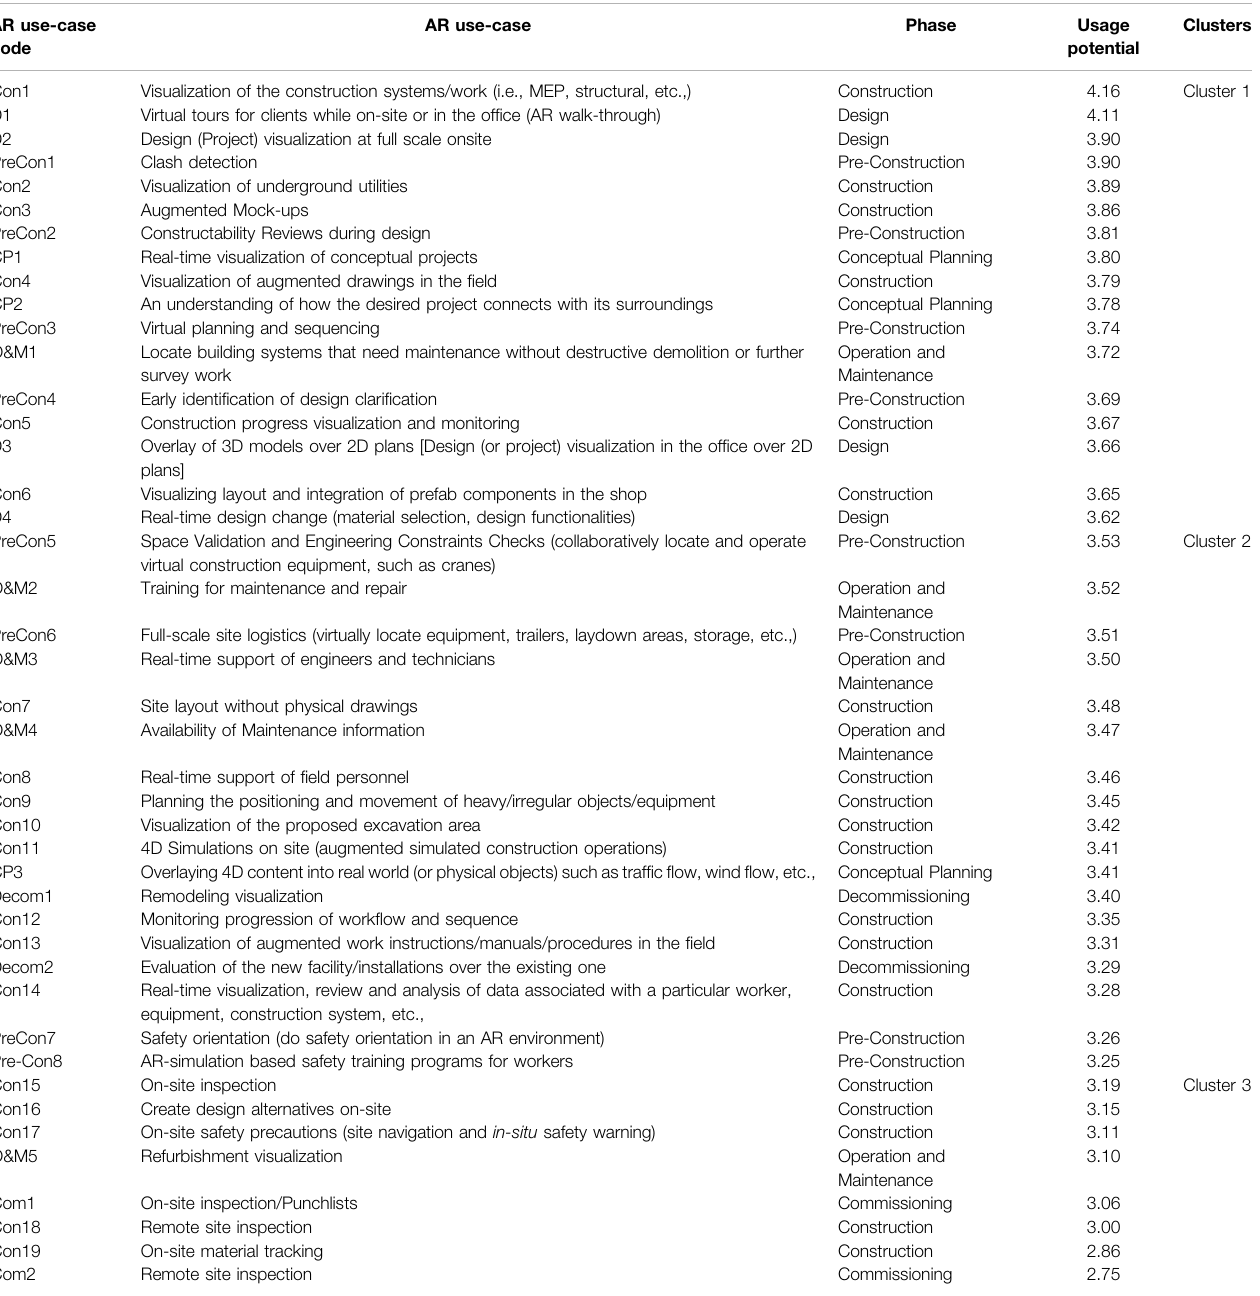
TABLE 1 | Clustered table of AR